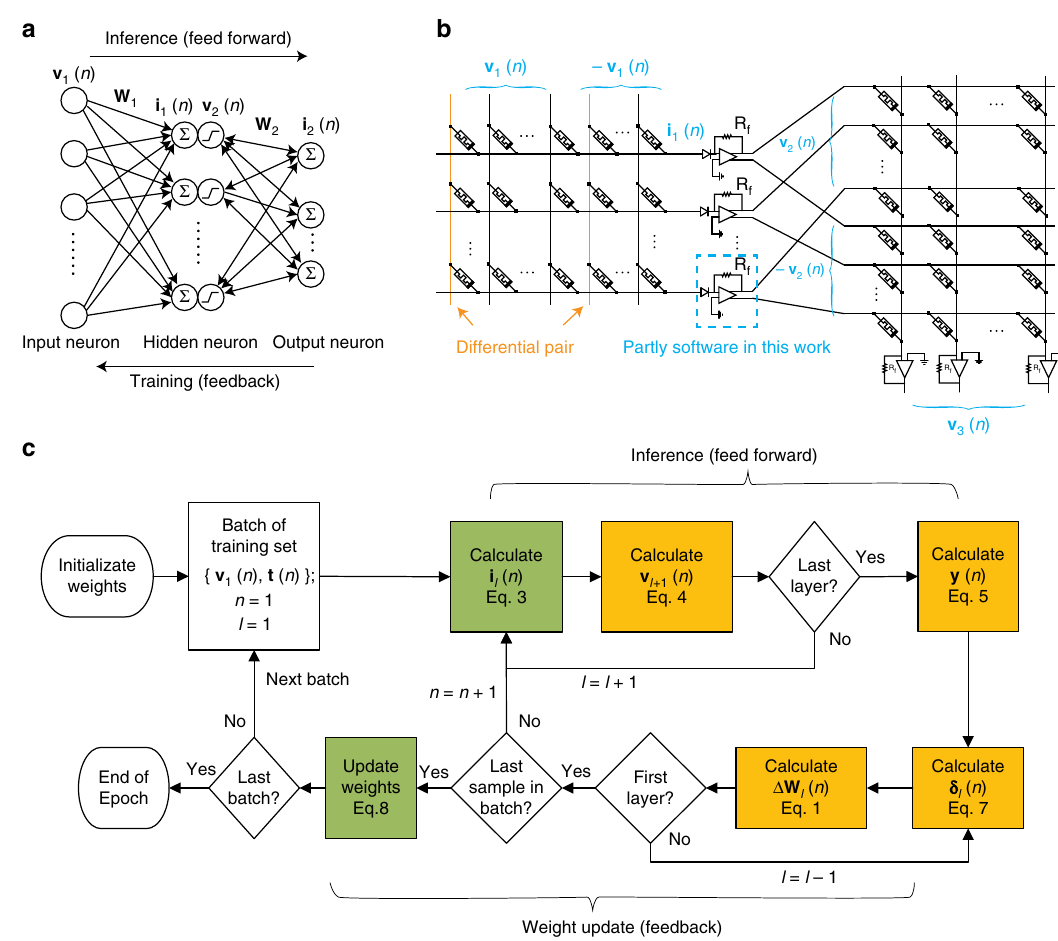
Fig. 2 In situ training algorithm. a Schematic diagram of a two-layer neural network. Each neuron computes a weighted sum of its inputs and applies a nonlinear activation function. b The implementation of the network with a set of memristor crossbars. Each synaptic weight (arrows in a ) corresponds to the conductance difference between two memristors (as illustrated by the orange columns). Each crossbar computes weighted sums of its input voltages. Between the crossbars is a layer of circuits that read the current from each wire, convert it to a voltage, and apply the activation function. The activation function was implemented in software in this work. c Flow chart of the in situ training. Steps in green boxes were implemented in hardware in this work, while those in yellow boxes were computationally expensive steps that can be accomplished with circuits integrated onto the chip in the future. The algorithm is described in detail in